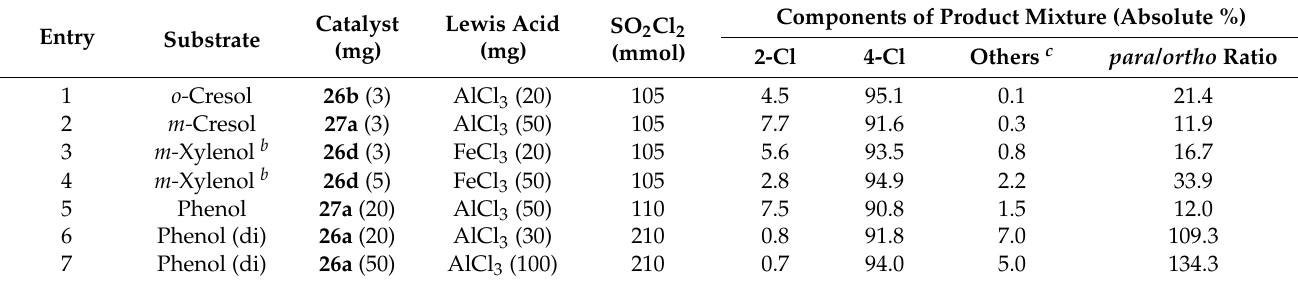
Table 5. Some results with small quantities of catalysts a